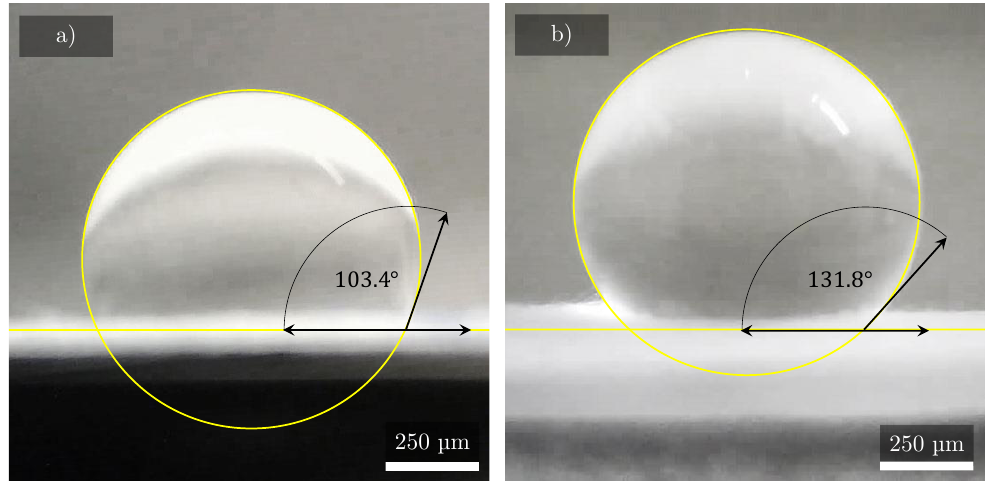
Figure 7. Captured images shows the hydrophobicity of the same type of PVDF without any fillers, produced by the method of electrospinning with different rotation of the collector cylinder. The figure shows the contact angle of a 3 µ L distilled water droplet on the PVDF nanofiber mat. Sample ( a ) was made with the rotation of 300 rpm, and sample ( b ) with the rotation of 2000 rpm. The difference in contact angle is almost 30 ◦